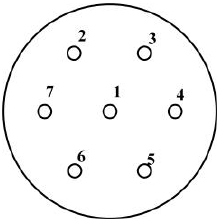
Fig. 1. Structure diagram of seven core optical